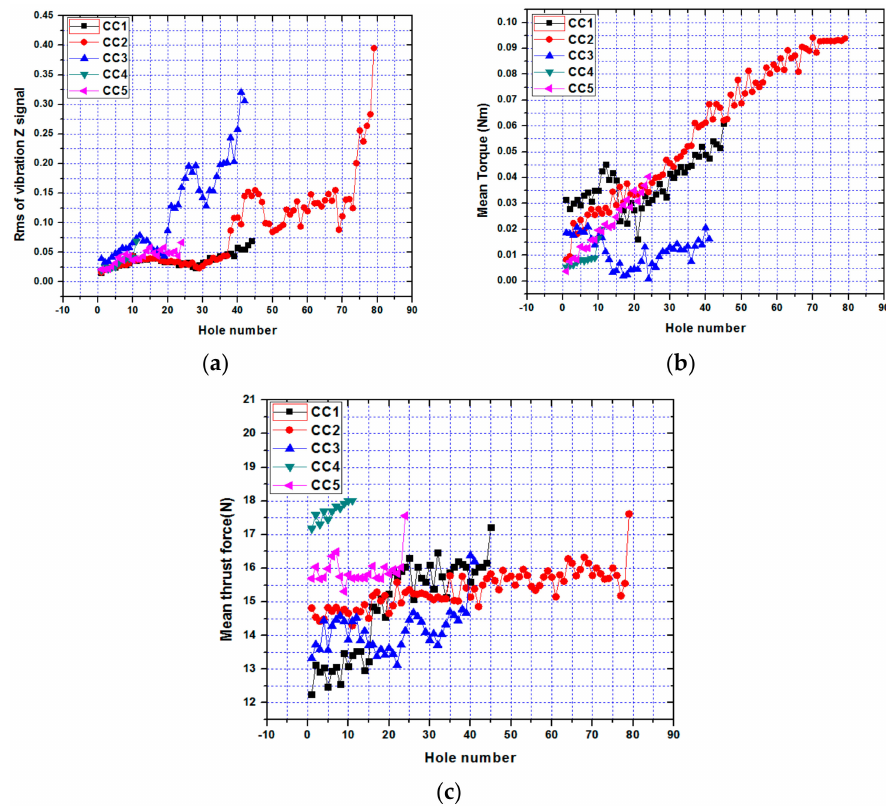
Figure 2. The variations of ( a ) vibration, ( b ) thrust force and ( c ) torque features with respect to the hole